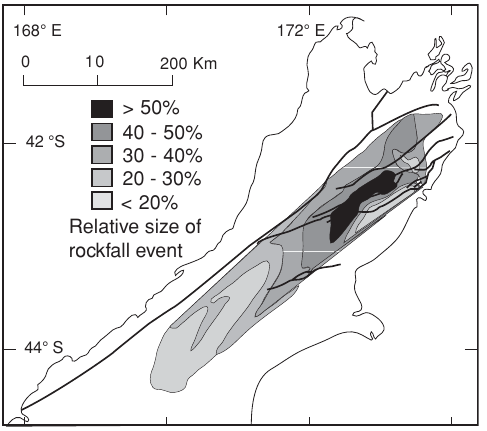
Fig. 8. Peak-size map for the 29 mm regional rock- fall event shows one area of seismic shaking in the center of the study region. Contours show the per- centage of 29 mm modeled peak size relative to all lichen-size measurements between 27 and 33 mm. From fig. 23B of Bull and Brandon